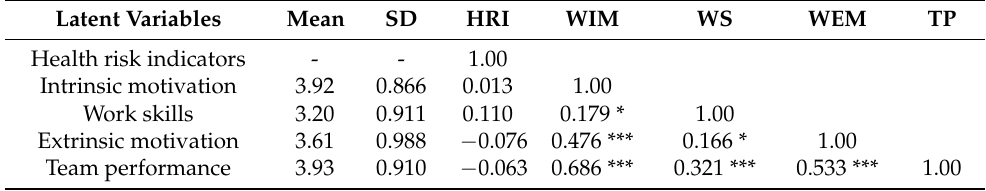
Table 4. Correlation matrix and descriptive statistics for the young workers’ group (Group A).